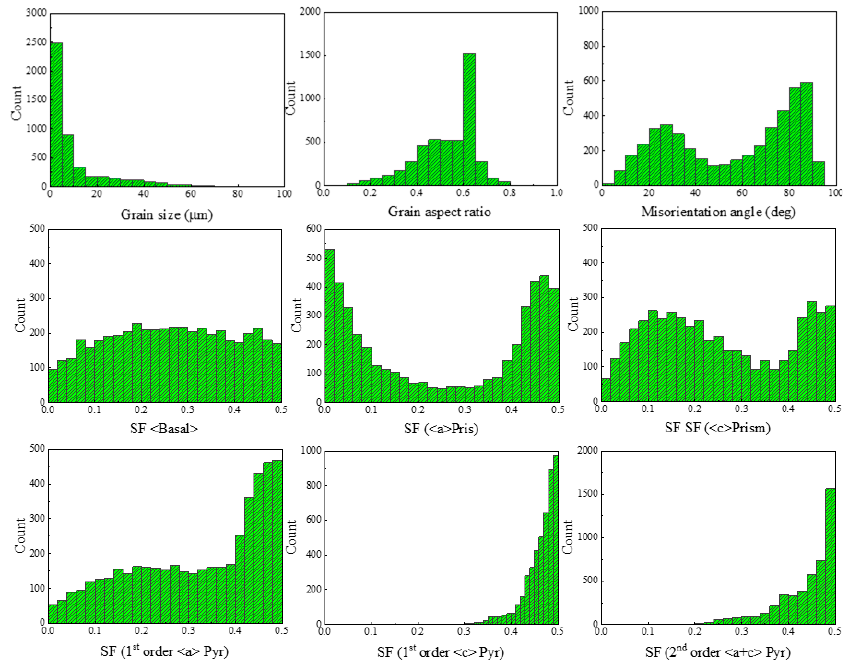
Figure 3. Histograms showing the distribution of the micrometrical parameters extracted from the maps presented in Figure 2 to be employed in the present learning work.